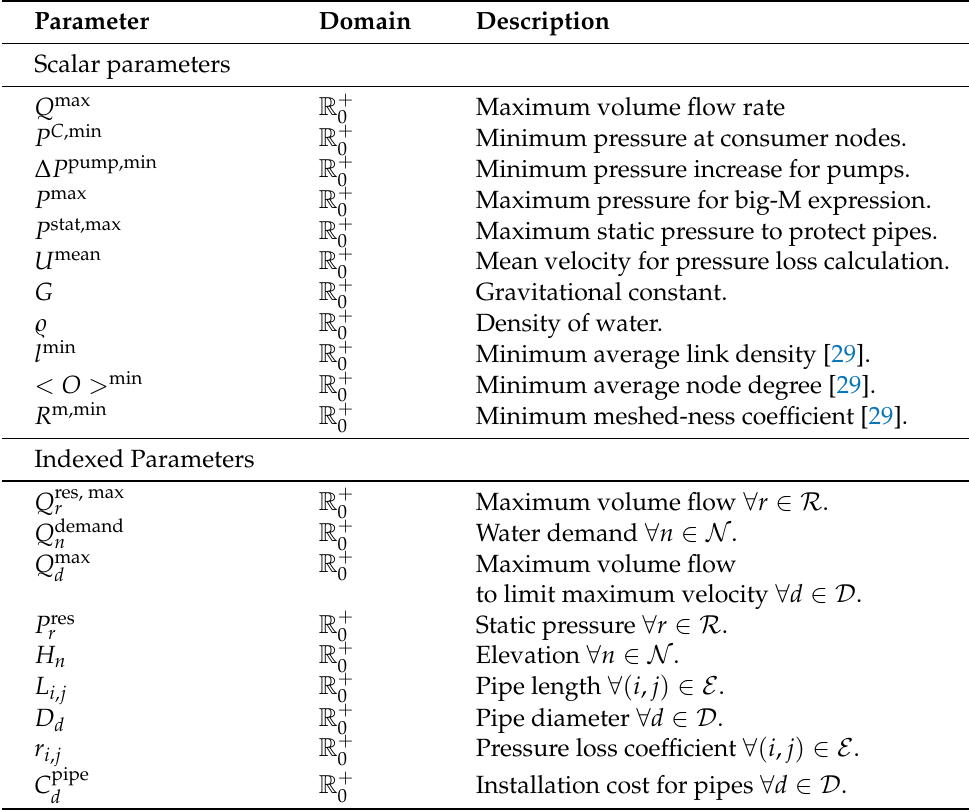
Table 4. Parameters defining the optimization